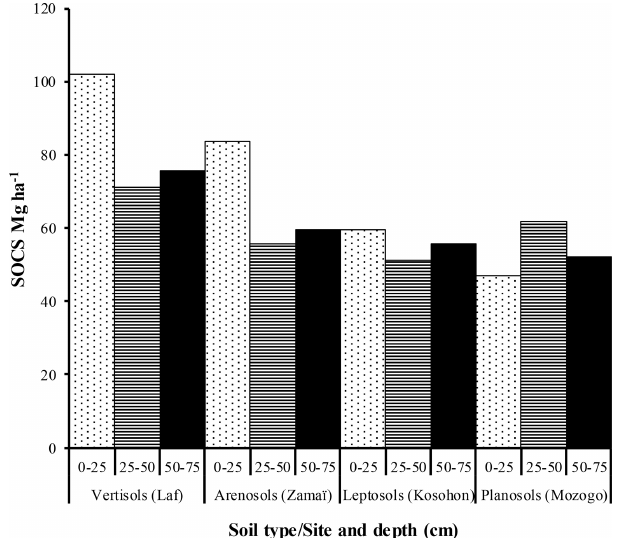
Figure 3. Variation of SOCS along the soil profiles in the study